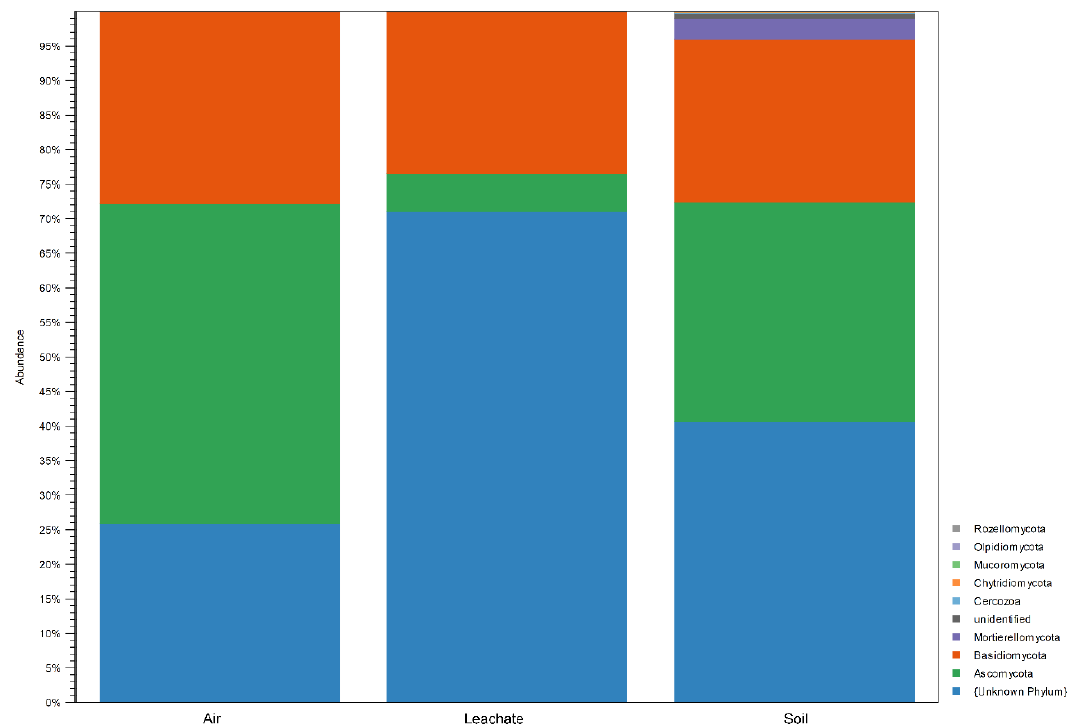
Figure 8. Percentage share of identified fungi at the Phylum level based on the ITS region analysis.